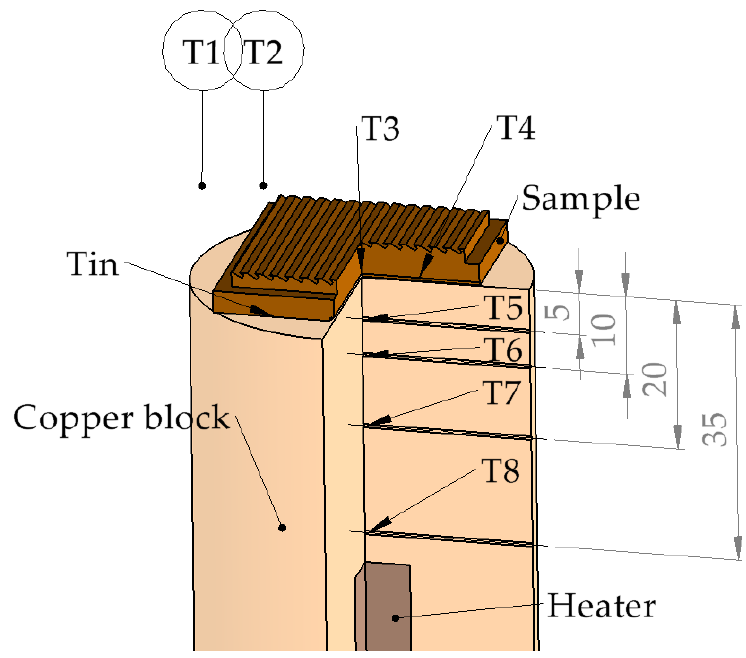
Figure 4. The arrangement of the temperature sensors on the test bench.